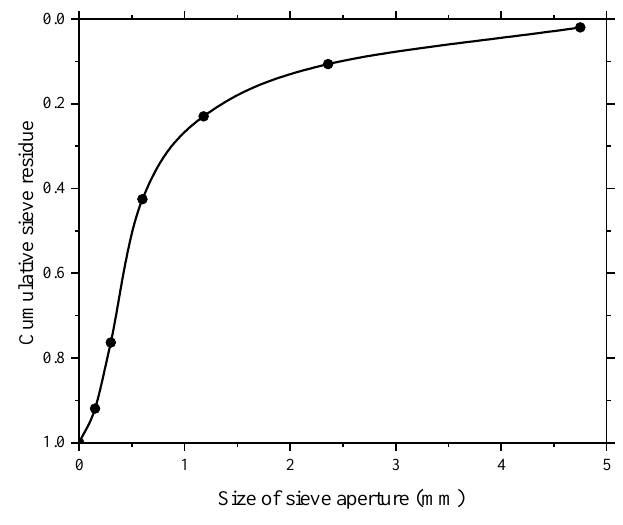
Figure 5. Sieve curve of fine aggregate.